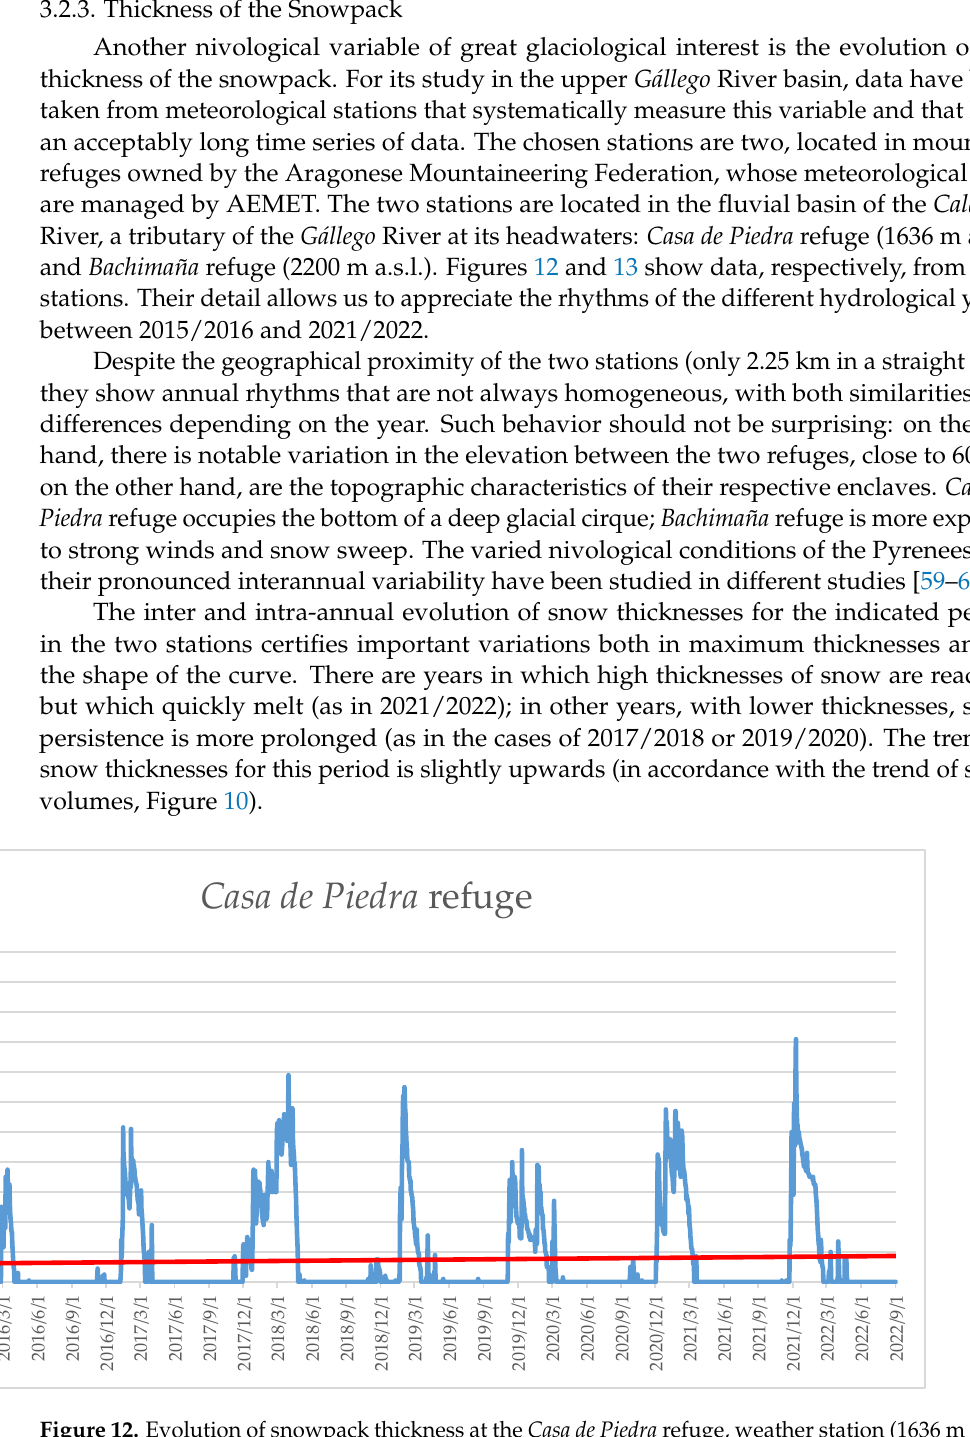
Figure 12 . Evolution of snowpack thickness at the Casa de Piedra refuge, weather station (1636 m a.s.l.). September 2015 – September 2022. Trend line (red). Base data: daily snow depth. Data source: AEMET [50].